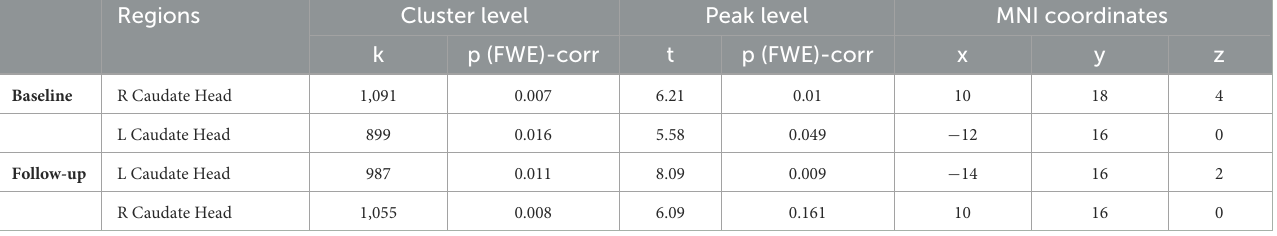
TABLE 2 Gray Matter (GM) cross-sectional analyses: comparisons between relapsers and abstainers: Relapsers > Abstainers.